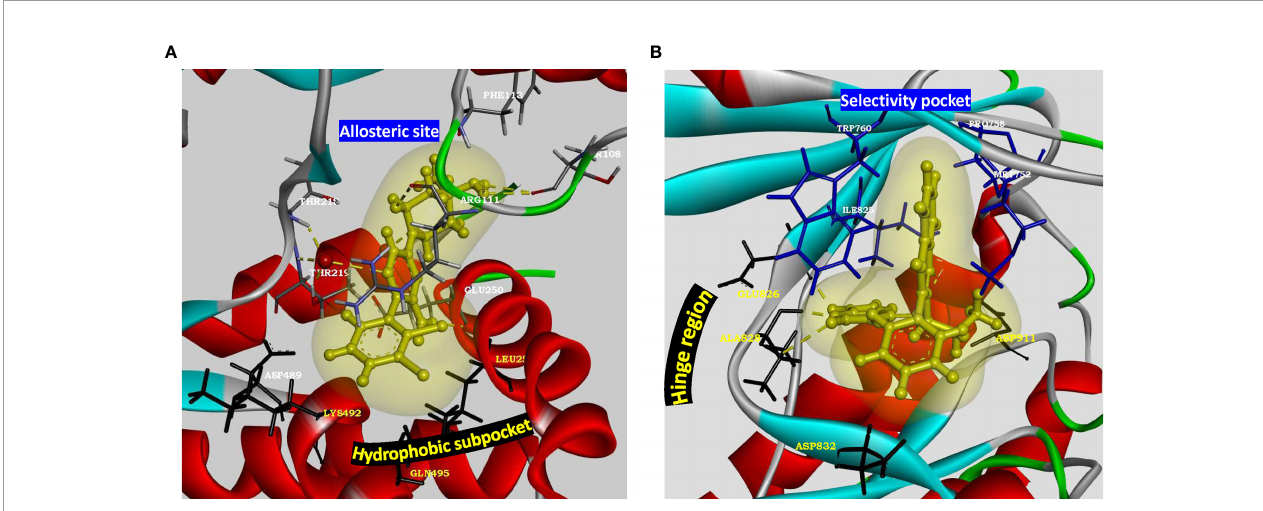
FIGURE 4 | Structural parameters of SHP2 and PI3K d for drug design. (A) Characterization of allosteric site present in SHP2 (PDB: 5EHR). Key residues of allosteric site (Thr218, Arg111, Phe113 and Thr108) are shown to form water mediated hydrogen bonds with the preclinical inhibitor PCC0208023. Hydrophobic subpocket presents residues Leu254 and Gln495 along with Asp489 and Lys492 for novel pharmacophore design and optimization. Allosteric site residues are rendered as sticks colored by element, hydrophobic pocket residues are rendered as black sticks, oxygen atom of water as red ball and inhibitor as yellow ball and stick model with its soft surface in light yellow and hydrogen bond interactions in yellow dashed lines. (B) Characterization of active site of p110 catalytic subunit of PI3K d (PDB: 4XE0). Hinge region residues (Glu826, Ala828, Asp832) provide hydrogen bond interactions. Hydrophobic pocket formed by gatekeeper residue Trp760 along with Met752, Pro758 and Ile825 may be targeted for adding selectivity in inhibitor design for delta isoform of PI3K. Kinase domain is rendered as solid ribbon colored according to secondary structure. Hinge region residues are rendered as black sticks, selectivity pocket residues as blue sticks, inhibitor as yellow ball and stick model with its soft surface depicted in light yellow and hydrogen bond interactions as yellow dashed